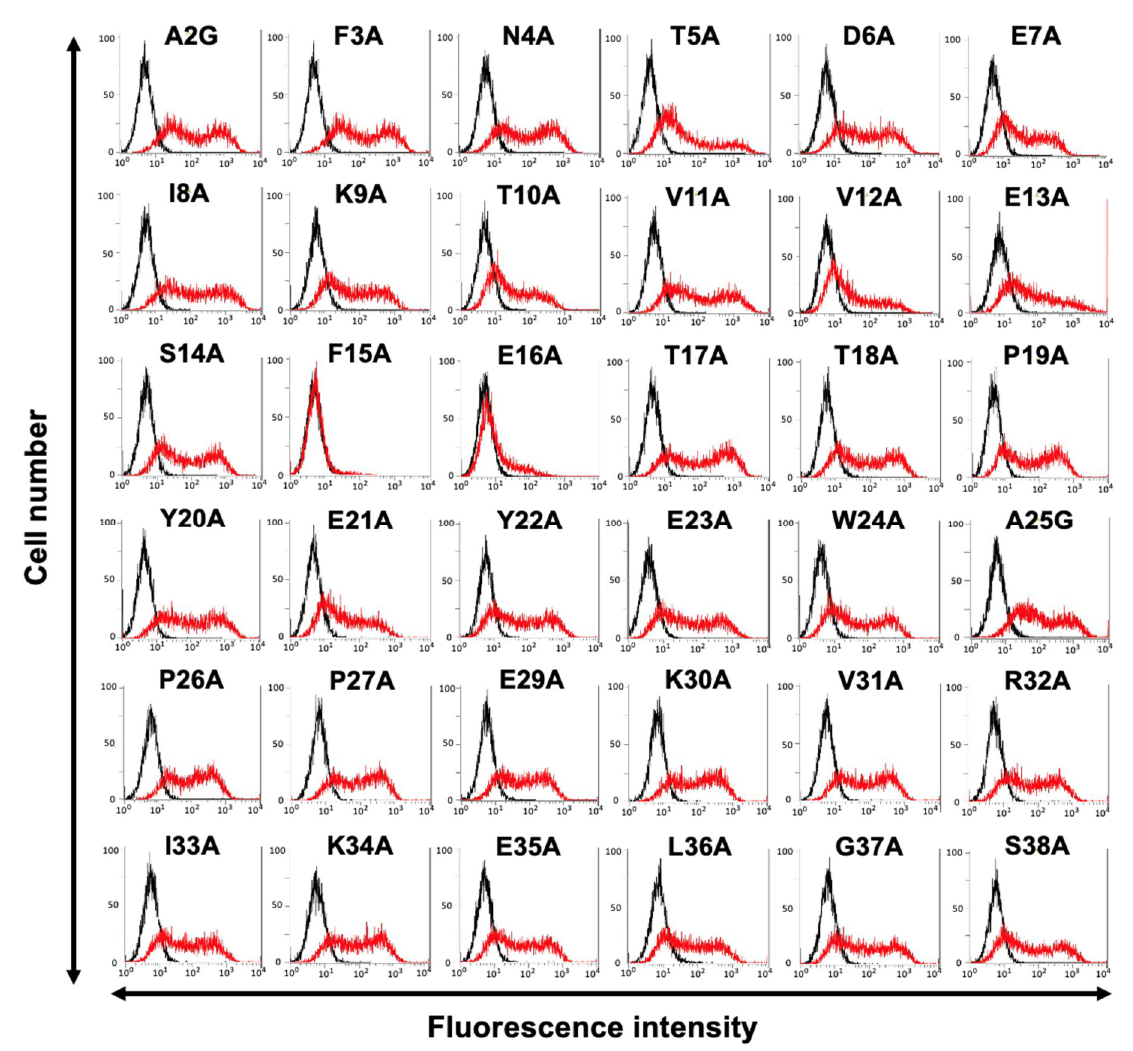
Figure 6. Cell surface expression of mCCR3 mutants on CHO-K1 cells using flow cytometry. C 3 Mab-7 (1 μg/mL) was treated with CHO-K1 cells that transiently expressed mutant proteins for 30 min at 4 °C, followed by the addition of Alexa 488-conjugated anti-rat IgG. Red lines show the cells with C 3 Mab-7 treatment, and black lines show cells without Ab treatment as a negative control.